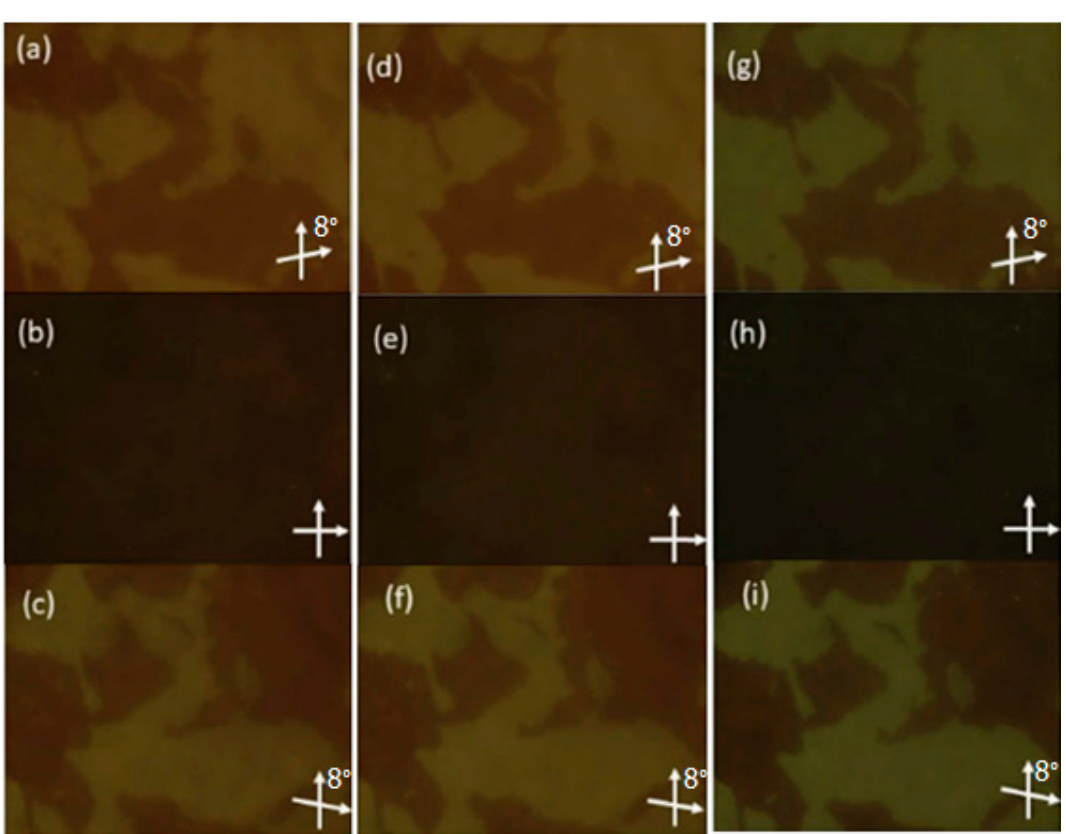
Figure 7. The optical texture of DC 1 * obtained for compound 25b at 170 °C: ( a , c ) between the uncrossed polarizers by an angle of about 8° and ( b ) between crossed polarisers; ( d – f ) textures of DC 2 * obtained under the same conditions as observed ( a – c ), at 158 °C; ( g – i ) textures of Cr* obtained at the room temperature [115].